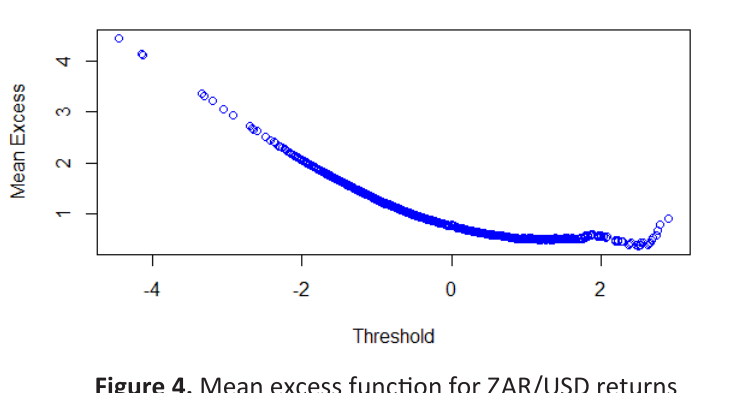
Figure 4. Mean excess function for ZAR/USD returns Table 4. Maximum likelihood estimates (MLE) of GARCH (1,1) residuals from ZAR/USD to the Generalized Pareto Distribution